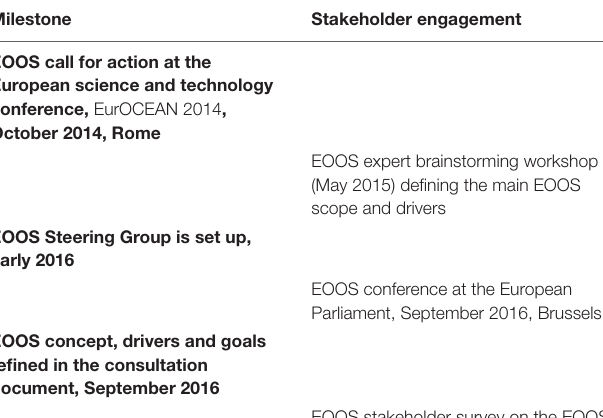
TABLE 1 | Milestones in the EOOS development and stakeholder